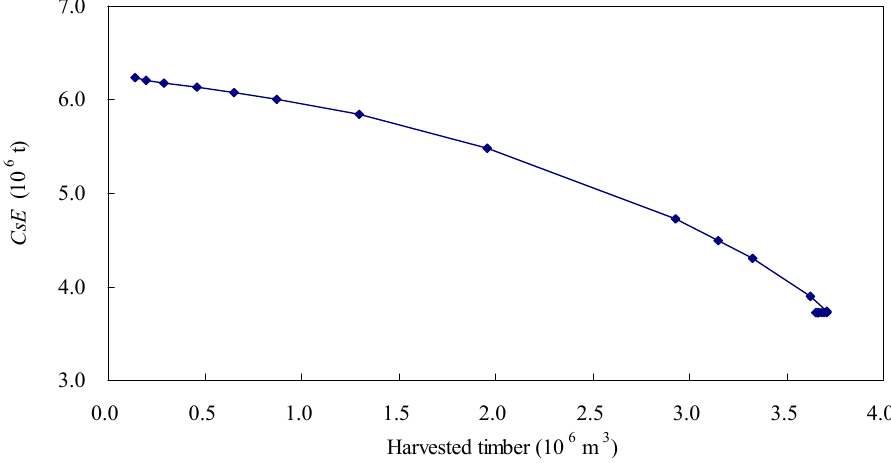
Figure 3. Trade ‐ offs between harvested timber and the CsE for a 30 ‐ year time frame when carbon prices varied from zero to 5000 ¥/ton, where CsE represents the levels of carbon stocks in living tree biomass at the end of the planning horizon.